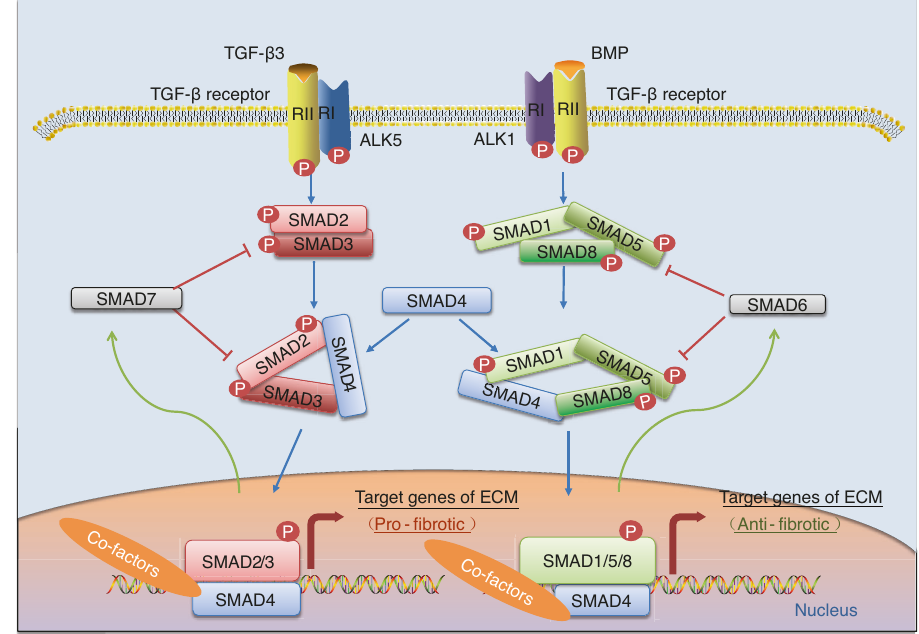
Fig. 2 Schematic diagram showing the transforming growth factor-beta 3 (TGF- β 3)-mediated R-Smad-dependent signaling pathway. Smad proteins transduce signals from the cell membrane to the nucleus and regulate gene expression after TGF- β 3 binding to a TGF- β receptor (T β R). TGF- β 3 plays a dual role in articular cartilage. It is involved in cartilaginous homeostasis via the classical Smad2/3 pathway and chondrocyte hypertrophy via the Smad1/5/8 pathway. The partner common to both pathways, Smad4, and inhibitory Smads (Smad6 and Smad7) play important roles. BMP bone morphogenetic protein, ALK1 activin receptor-like-kinase 1, ALK5 activin receptor-like kinase